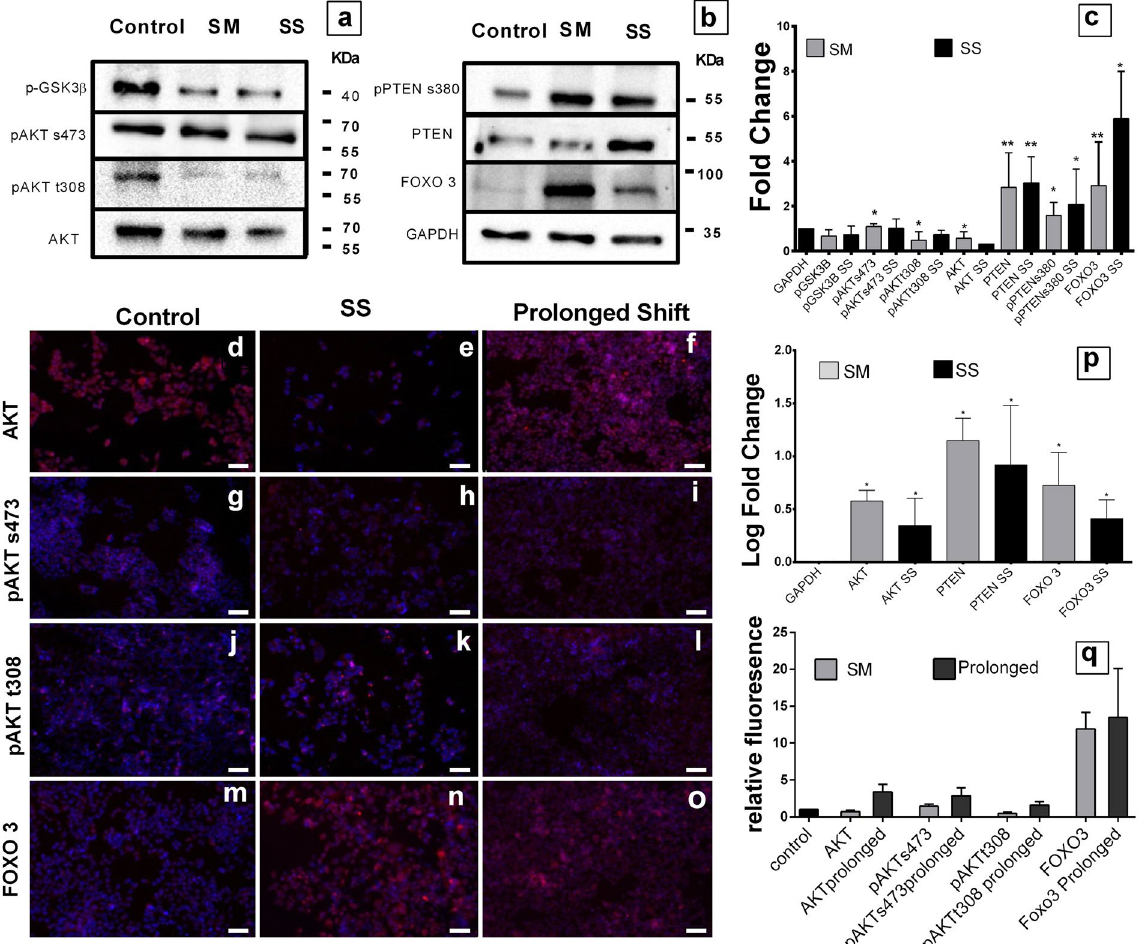
Figure 8. The PTEN/FOXO3/AKT axis regulation under microgravity. Images of Western blot for AKT pathway proteins; phosphorylated GSK-3 β serine 9, phosphorylated AKTserine 473, phosphorylated AKT threonine 308 and total AKT of control, Microgravity simulated and SM cells shifted to normal gravity for 4 days (SS) ( a ). Western Blot images of phosphorylated PTEN serine 308, PTEN, FOXO3 and GAPDH ( b ). Representative graph normalized using GAPDH; black bars represent SS and lighter bars represent SM ( c ). Data represented as mean + S.D. statistical analysis using Mann Whitney t test * P < 0.05, ** P < 0.005. Fluoresecnt images of DLD1 cells stained with PE conjugated secondary against AKT, pAKTs473, pAKTt308 and FOXO3, nucleus counterstained with DAPI, control ( d , g , j , m ) respectively and SS cells ( e , h , k , n ) and SM cells prolonged in static for longer period 2 months ( f , i , l , o ) scale bar = 200 μ m. qPCR analysis of Gene expression of AKT , PTEN, FOXO genes against GAPDH as housekeeping in control vs SM and SS, represented in log fold change of mean + S.D. * P < 0.05 ( p ). Graphical representation for the images ( d – o ) showing relative fluorescence intensity between control, SS and prolonged shift cells ( q